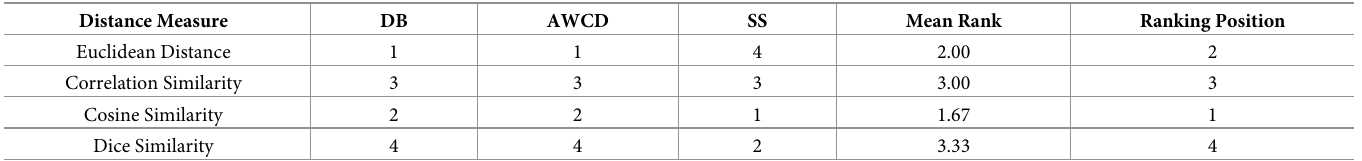
Table 8. Final score ranking to select the best distance measure.